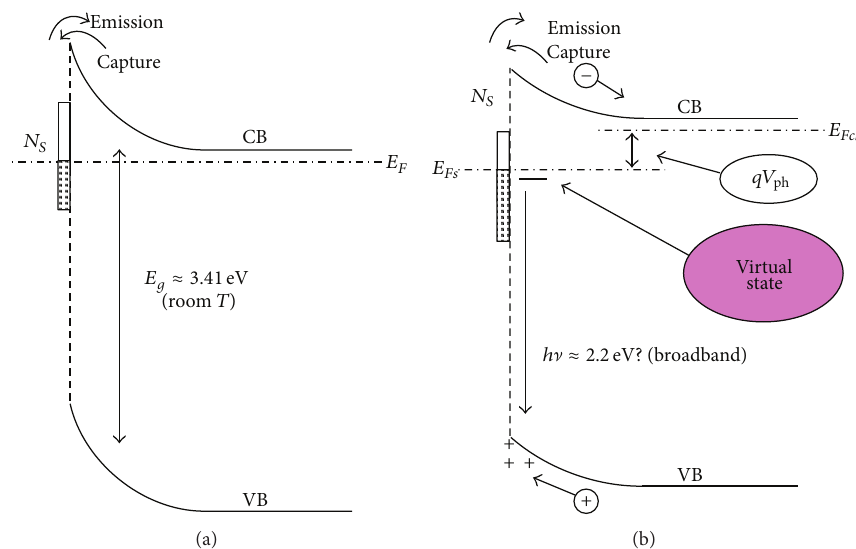
Figure 1: (a) Band diagram of n-GaN Device no. 1 near its surface in thermal equilibrium (TE). (b) Band diagram of Device no. 1 out of TE during a photoluminescence